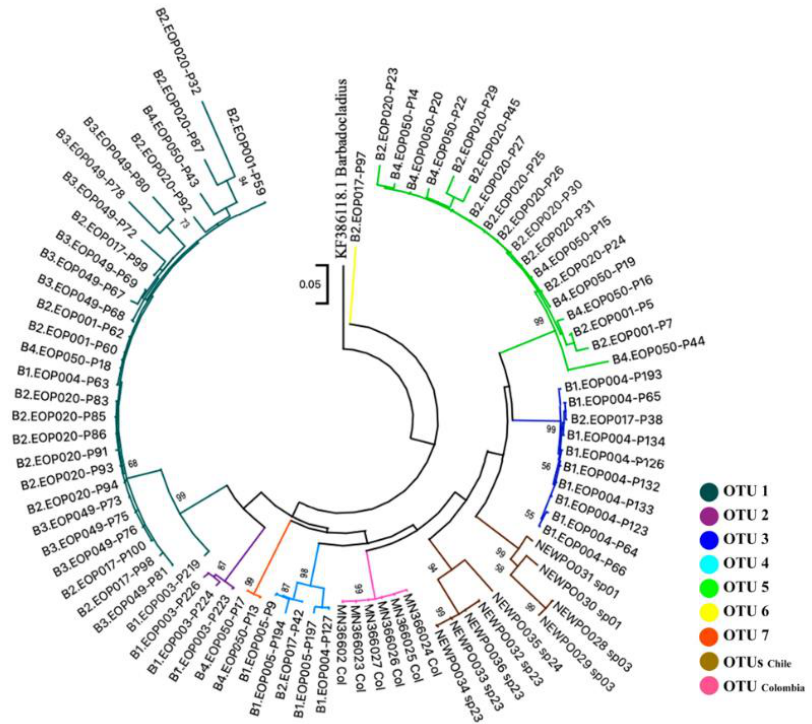
Figure 5. Maximum likelihood tree of Polypedilum specimens based on partial COI sequences and the Tamura-Nei model. Barbadocladius sp. appears as an outgroup. Branch numbers are 500 replicate bootstrap support (>50%); scaling represents K2P genetic distance; distinct colors represent different OTUs.